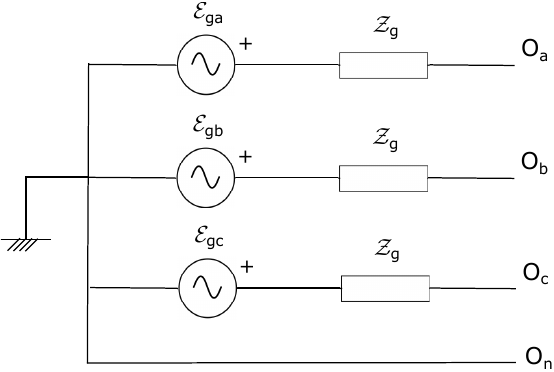
Figure 2. Thévenin equivalent for a medium-voltage (MV)